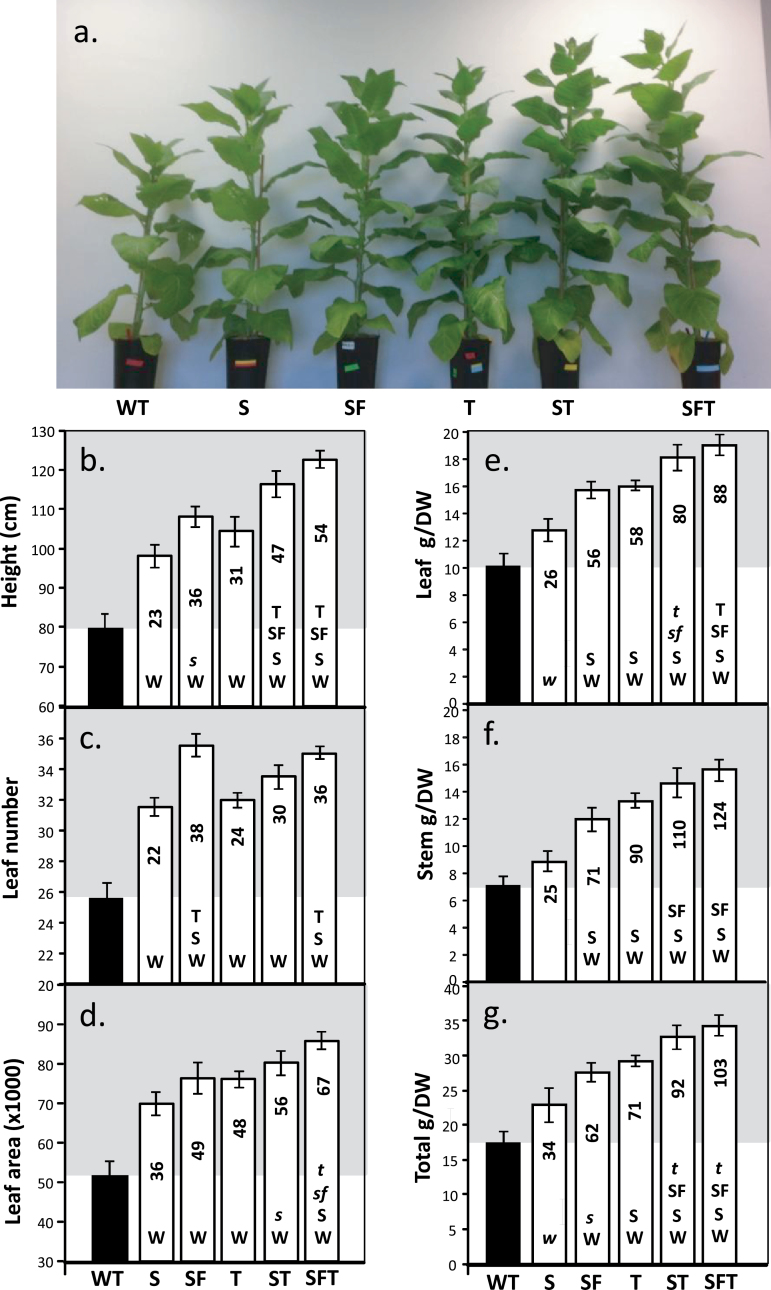
Growth analysis of WT and transgenic plants grown in greenhouse conditions. Plants were grown for 2 weeks at 130 μmol m–2 s–1 light intensity in long days (12/12h days) before being transferred to the greenhouse and supplemented light (16/8h days), at maximum 600–1400 μmol m–2 s–1 light intensity for an additional 4 weeks (6 weeks in total). Plants were harvested when the first sign of flower development became apparent. (a) Appearance of plants 6 weeks after planting. Lines over-expressing SBPase (S), SBPase and FBPA (SF), ictB (T), SBPase and ictB (ST), and SBPase, FBPA, and ictB (SFT) are represented. (b) Plant height, (c) leaf number, (d) leaf area, and (e–g) biomass. Results are representative of 4–5 plants from 3–4 individual lines (12–16 plants in total). Significant differences (<0.05) are represented by capital letters indicating if each specific line is significantly different from another. Lower case italic lettering indicates lines that are just below significance (>0.05 and <0.1). The percentage increases over the wild type are indicated.